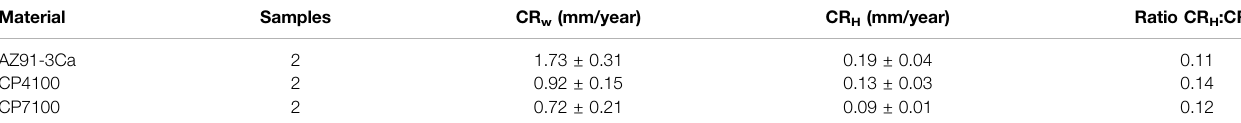
TABLE 3 | Average corrosion rates calculated from immersion test data presented with a ratio of CR H to CRw for comparison. Material